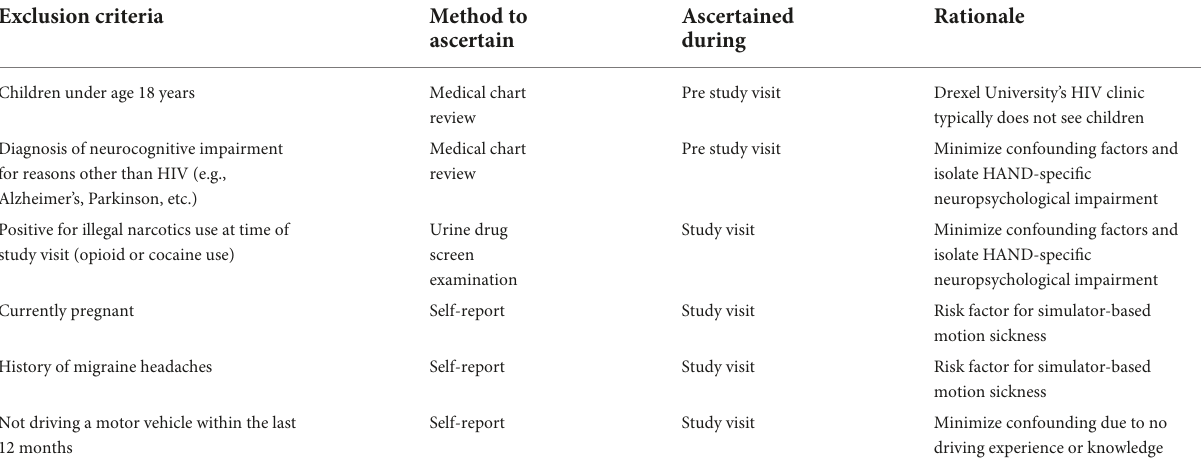
TABLE 1 Study exclusion criteria.